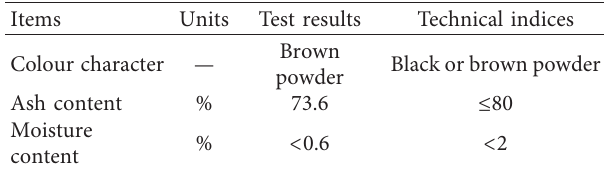
Table 1: Technical index of BRA.